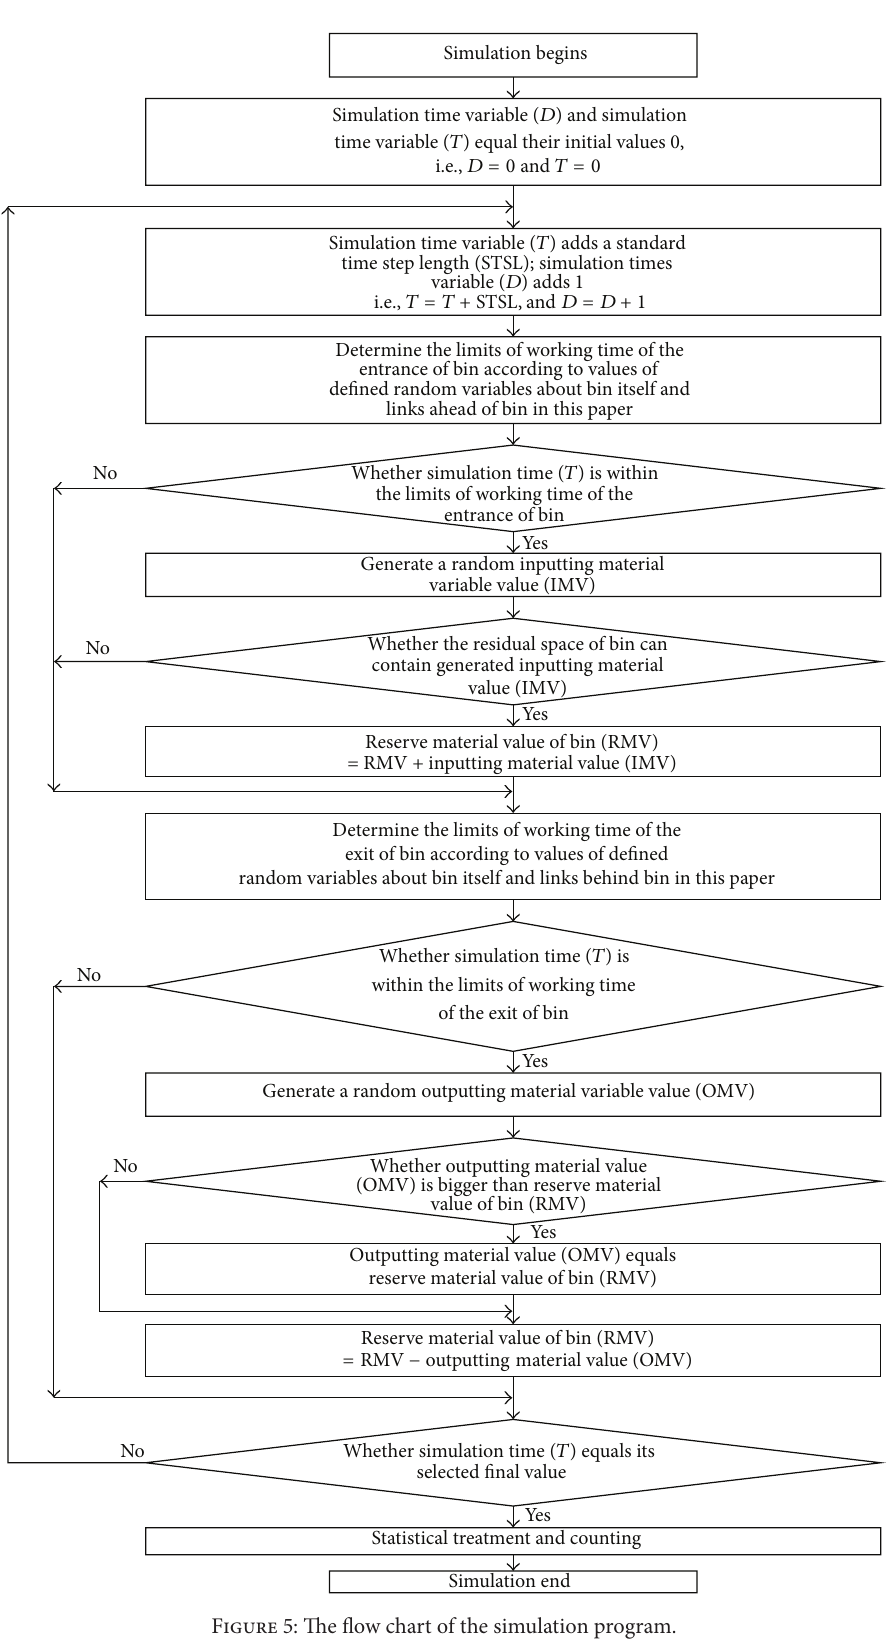
Figure 5: The flow chart of the simulation